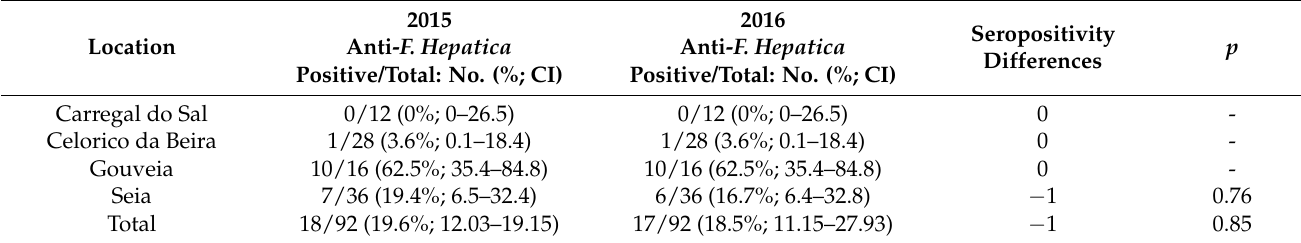
Table 1. Occurrence of F. hepatica IgG seropositive Serra da Estrela sheep sampled in the years 2015 and 2016. Location